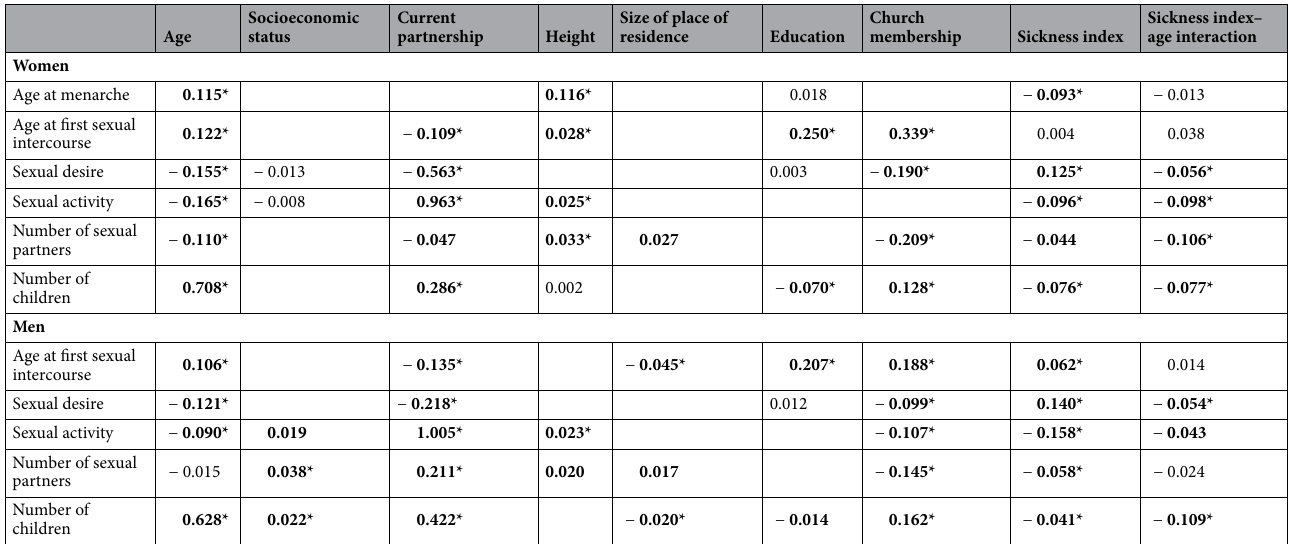
Table 2. Associations of the sickness index and covariates with each variable related to sexual life and reproduction. This table shows the results (standardised beta coefficients) of eleven univariate GLM analyses (Type III sums of squares) analysing associations between variables related to sexual life and reproduction (first column) and the sickness index and covariates. In accordance with the preregistration, each model includes only covariates with Kendall’s Tau > 0.02 or < − 0.02 for correlation with output variables (see Supplementary Table S3). Current partnership and church membership were treated as binary variables with 0 indicating no current partnership and no church membership, and 1 indicating being in a partnership and church membership. A positive beta therefore means that for example subjects currently in a partnership score higher on a particular variable. Associations with p values under 0.05 are in bold and those with p values under 0.005 are marked with